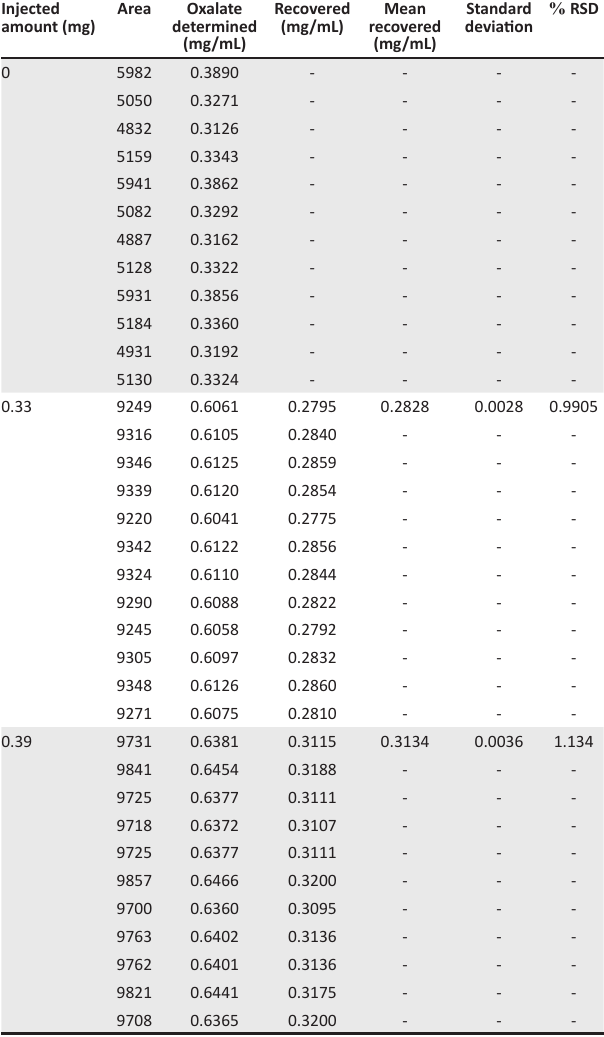
TABLE 4: Determination of precision (intra-day). Injected Area amount (mg)